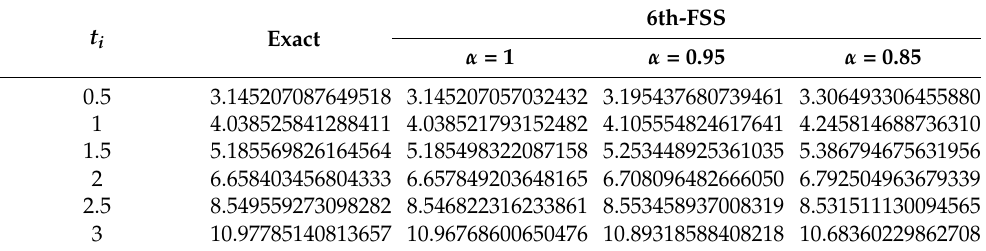
Table 2. Numerical solutions of the 6th FSS for the nonlinear time-FBPM (15).